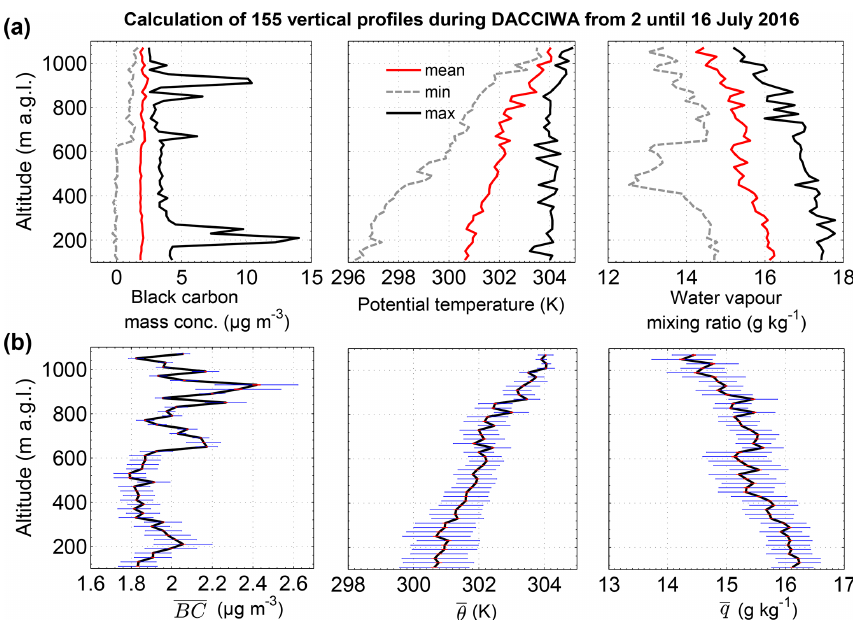
Figure 5. Summary of 155 vertical profiles from 100 to 1100ma.g.l. measured with ALADINA during the field experiment of DACCIWA on 2–16 July 2016. (a) Vertical profiles of black carbon mass concentration (BC) measured with the aethalometer and 10s low-pass filtering, potential temperature θ , and water vapour mixing ratio q . The red line represents the mean value, the grey dashed line stands for the total minimum, and the solid black line is the total maximum of all vertical profiles averaged in 20m altitude intervals. (b) The mean values of BC (BC), θ ( θ ), and q ( q ) in 20m steps and the corresponding standard deviation for each height interval. Table 1. Measurements performed with the UAS ALADINA during DACCIWA on 14–15 July 2016. The table presents the flight time in UTC, cloudy conditions indicated by the lowest cloud base, and gas concentration variations of NO x and CO during the corresponding flight time as a possible indicator for local emissions (sampled at the Savè supersite by UPS). Flight Day in Flight time Cloud base NO x CO